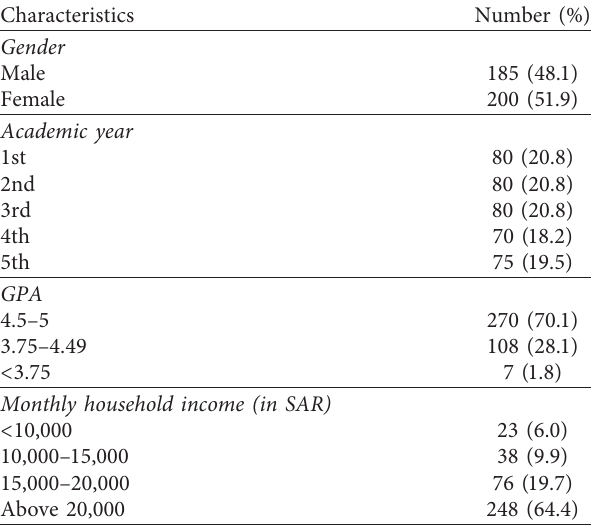
Table 1: Characteristics of the subjects ( n �